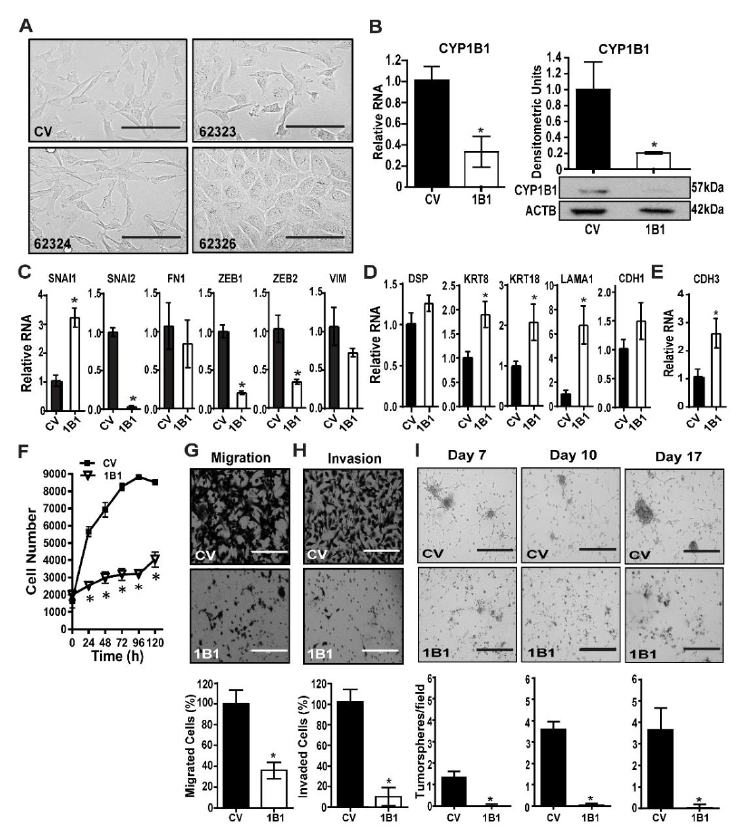
Figure 1. Stable CYP1B1 knockdown decreases mesenchymal phenotypes in MDA-MB-231 cells. ( A ) MDA-MB-231 cells were transduced with control vector (CV) or CYP1B1 short hairpin RNA (shRNA) Lentiviral Transduction Particles (62323, 62324, or 62326). Representative microscopic images at 200× magnification; scale bar, 200 µm. ( B ) Stable KD of CYP1B1 cell line 62326. Cells grown for more than 5 passages were analyzed for RNA ( left panel ) or protein normalized to ACTB ( right panel ). Values are the mean ± SD, n = 3, relative to CV, set at a value of 1.0. The * indicates a significant difference ( p ≤ 0.05) between CV and CYP1B1 KD (shRNA) cells by Student’s t- test. ( C ) Quantitative PCR (qPCR) analysis of mesenchymal marker transcripts. Values are the mean ± SD, n = 3, relative to CV. The * indicates a significant difference ( p ≤ 0.05) between CV and CYP1B1 KD cells (62326, here and below) by Student’s t- test. ( D ) qPCR analysis of epithelial marker transcripts. Values are the mean ± SD, n = 3, relative to CV. The * indicates a significant difference ( p ≤ 0.05) between CV and CYP1B1 KD cells by Student’s t- test. ( E ) qPCR analysis of CDH3 transcripts. Values are the mean ± SD, n = 3, relative to CV. The * indicates a significant difference ( p ≤ 0.05) between CV and CYP1B1 KD cells by Student’s t- test. ( F ) Cell proliferation was assayed at the indicated times. Values are the mean ± SD, n = 7; * indicates a significant difference ( p ≤ 0.05) between CV and 1B1 KD cells by two-way analysis of variance (ANOVA) followed by Tukey’s multiple comparisons. ( G ) Cell migration. Top , microscopic images of invading cells; scale bar, 200 µm Bottom , results